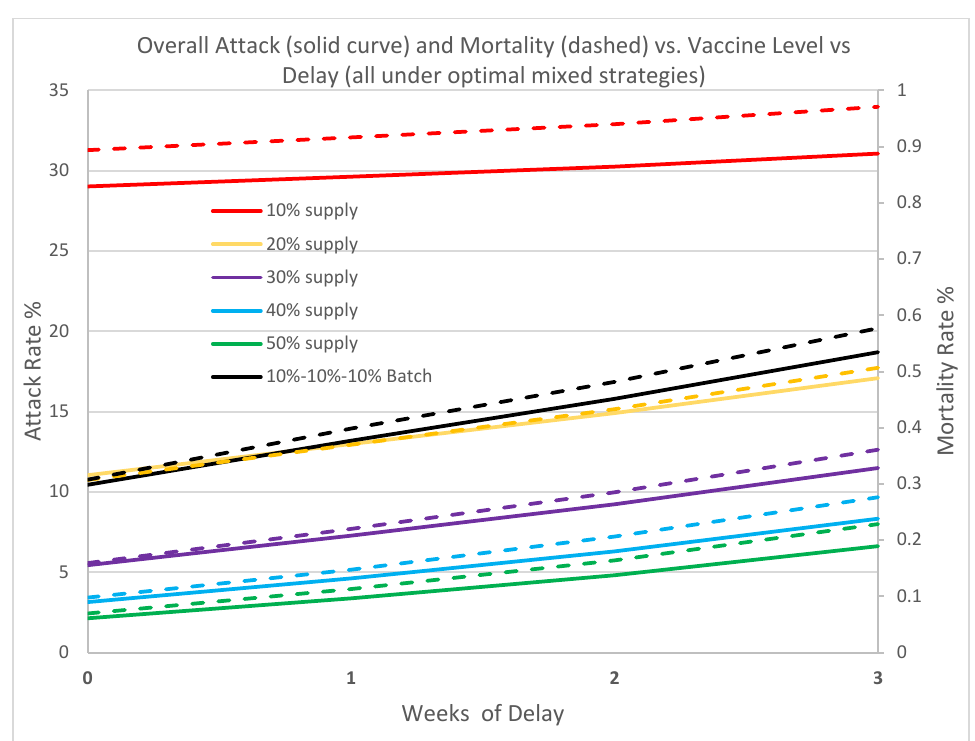
Figure 7. In this figure we contrast the overall attack rate and mortality rate (Day 0 to Day 180) associated with six different vaccine supply/delay scenarios, all operating under the optimal switch triggers. The solid lines denote attack rate, and the dashed lines denote the mortality rate. 𝑅 0 = 1.2, initial infection is 0.5%. Note the diminished effect of the batched supply (black).